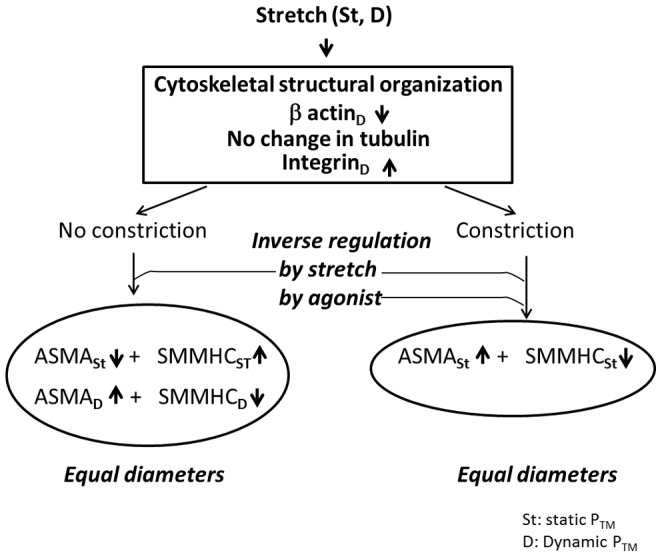
Proposed mechanism for the lack of stretch-induced airway dilation.The cytoskeleton and connection to ECM by integrins determine and regulate airway diameter through double inverse regulation of ASMA and SMMHC2 by stretch and agonist stimulation. Notice that without constriction (left), changes in protein levels are relative to their values at T0, whereas during constriction (right), changes in protein levels in the static condition are compared to their levels during dynamic conditions.